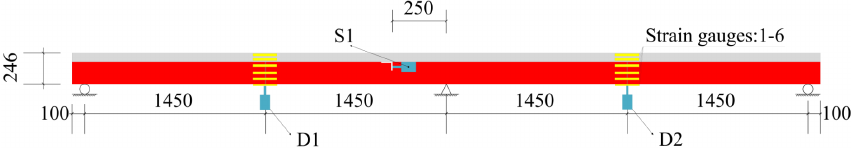
Figure 3. Arrangements of strain gauges and dial gauges.